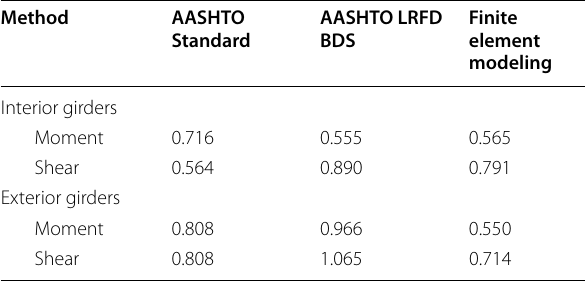
Table 2 Distribution factors of a tub girder bridge (reproduced from Hughs and Idriss